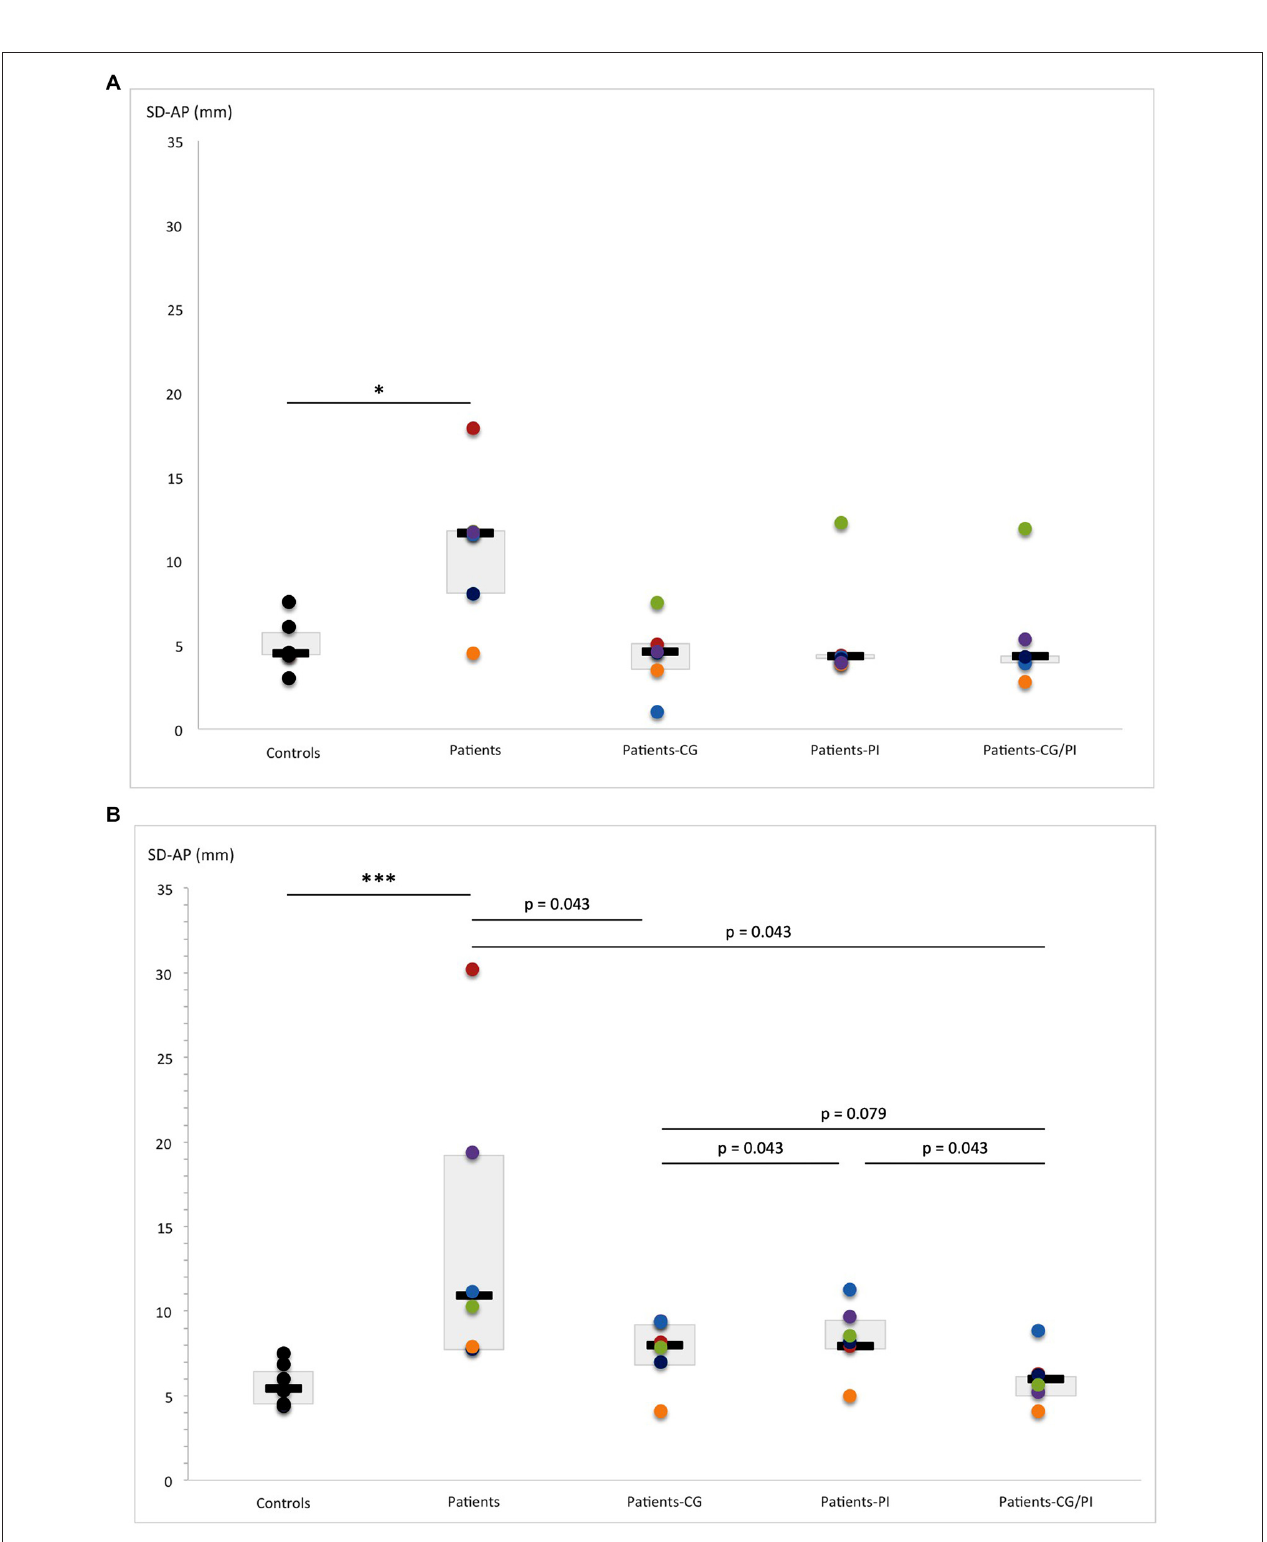
FIGURE 5 | Comparison of SD-AP (standard deviation of anteroposterior center-of-pressure (COP) displacement: mm) obtained by hEDS patients and controls, with and without somatosensory orthoses (CG, compression garments; PI, proprioceptive insoles; CG-PI, both somatosensory orthoses): in (A) eyes-open, and (B) eyes-closed conditions. Box plots represent median and quartiles, and dots represent performance of each participant as follows: controls: black; patient 1: red; patient 2: green; patient 3: purple; patient 4: light blue; patient 5: orange; patient 6: dark blue. ∗ p < 0.05, ∗∗∗ p < 0.005.